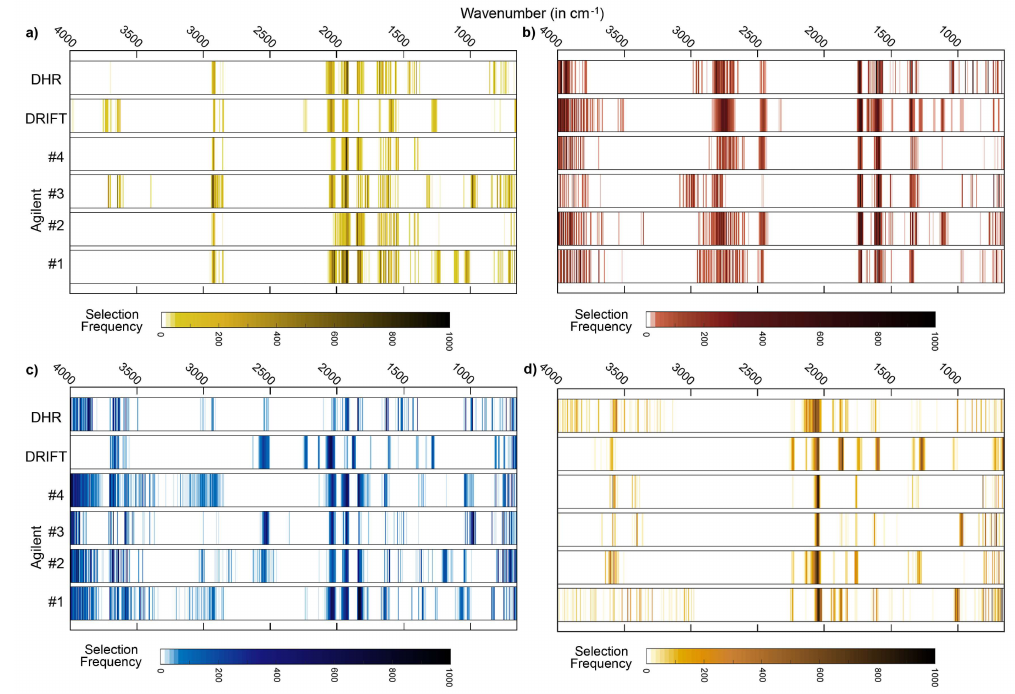
Figure 6. Heatmaps of wavenumber selection frequencies for ( a ) N, ( b ) pH, ( c ) clay content and ( d ) sand content provided by the applied Monte Carlo CV approach with the CARS spectral variable selection